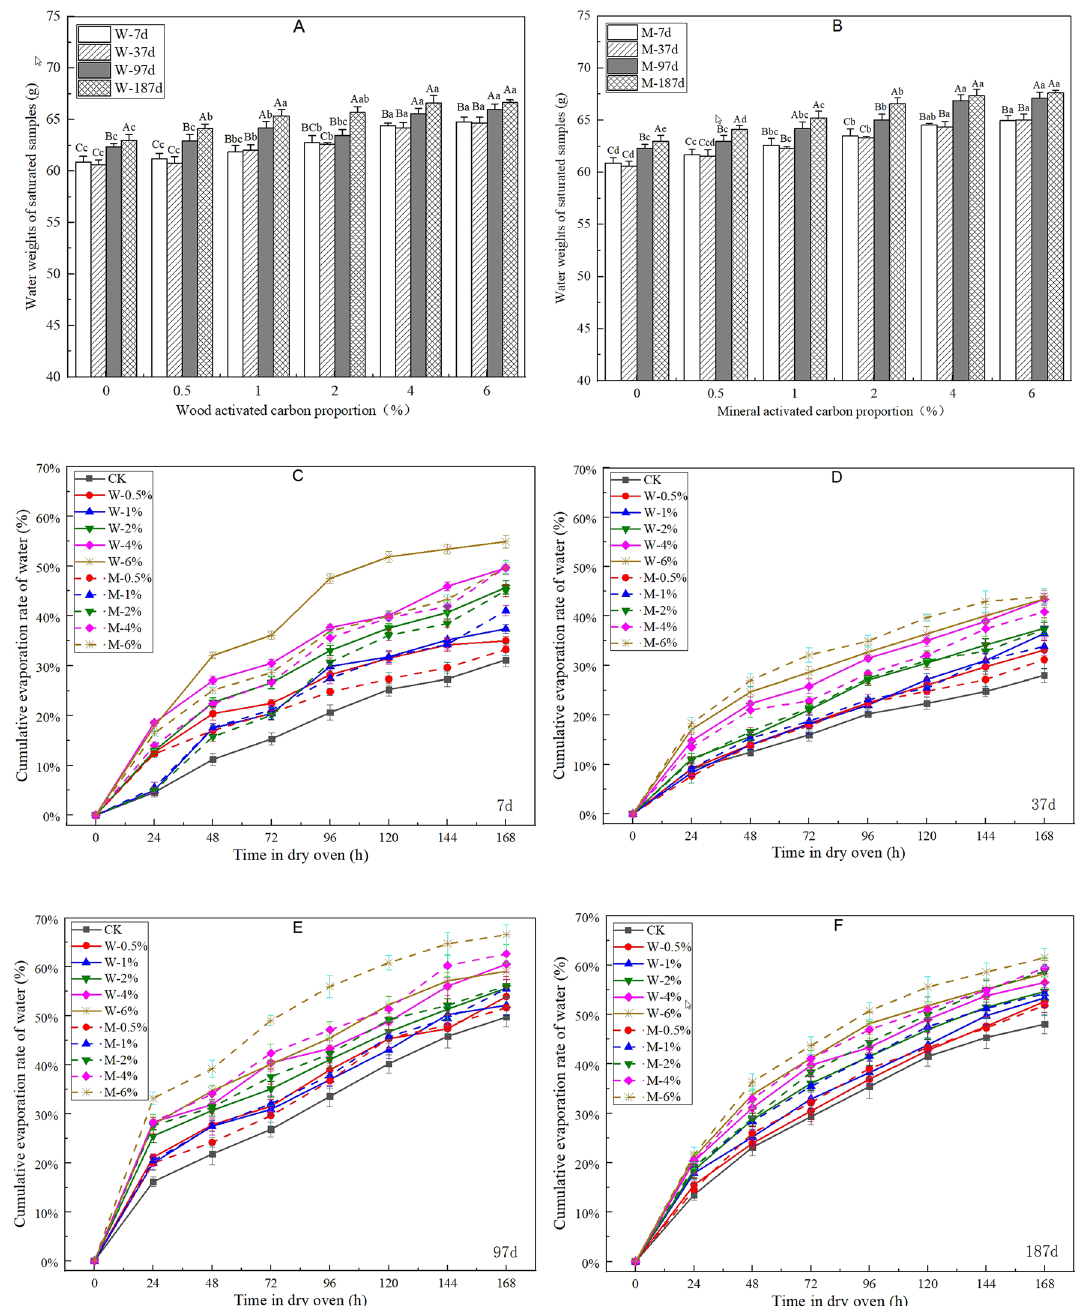
Figure 6. Effects of activated carbon on the water weight of saturated vegetation concrete ( A,B ) and cumulative evaporation rate of vegetation concrete ( C–F ) at different times. Different capital letters indicate significant differences between different times ( P < 0.05). Different small letters indicate significant differences between different activated carbon proportions ( P <